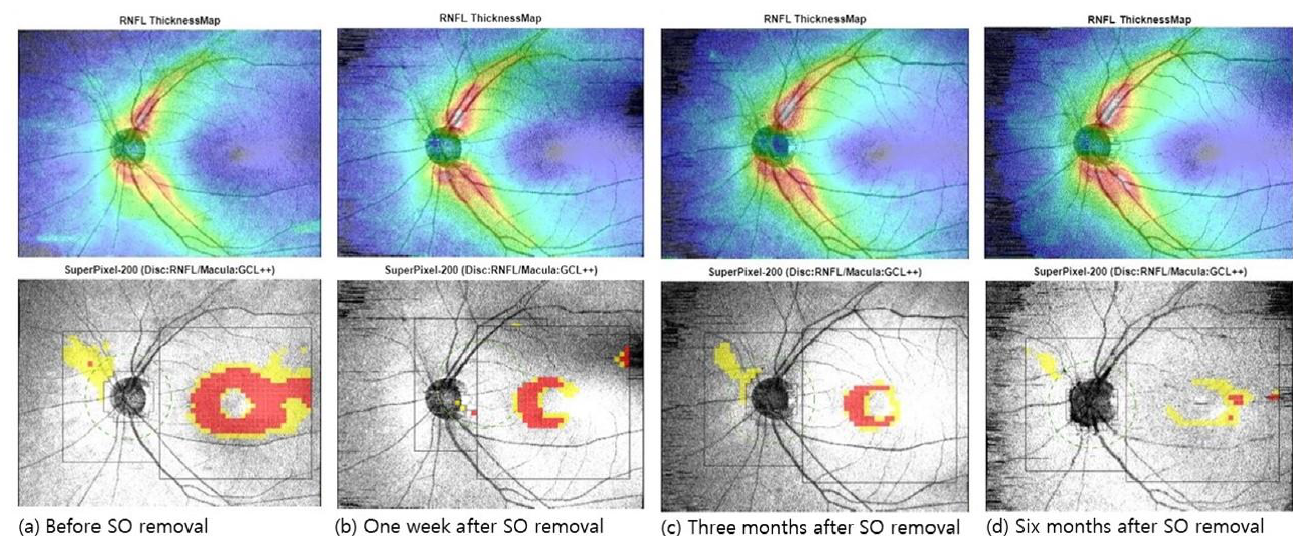
Figure 2. The upper row is the retinal nerve fiber layer (RNFL) thickness map, while the lower row is the deviation map for the disc RNFL and macular ganglion cell layer (GCL) thickness ( a ) before SO removal, ( b ) one week after SO removal, ( c ) three months after SO removal, and ( d ) six months after SO removal. Before SO removal, the parafoveal GCL thickness was decreased. Contrastingly, after SO removal, the thickness was gradually recovered.